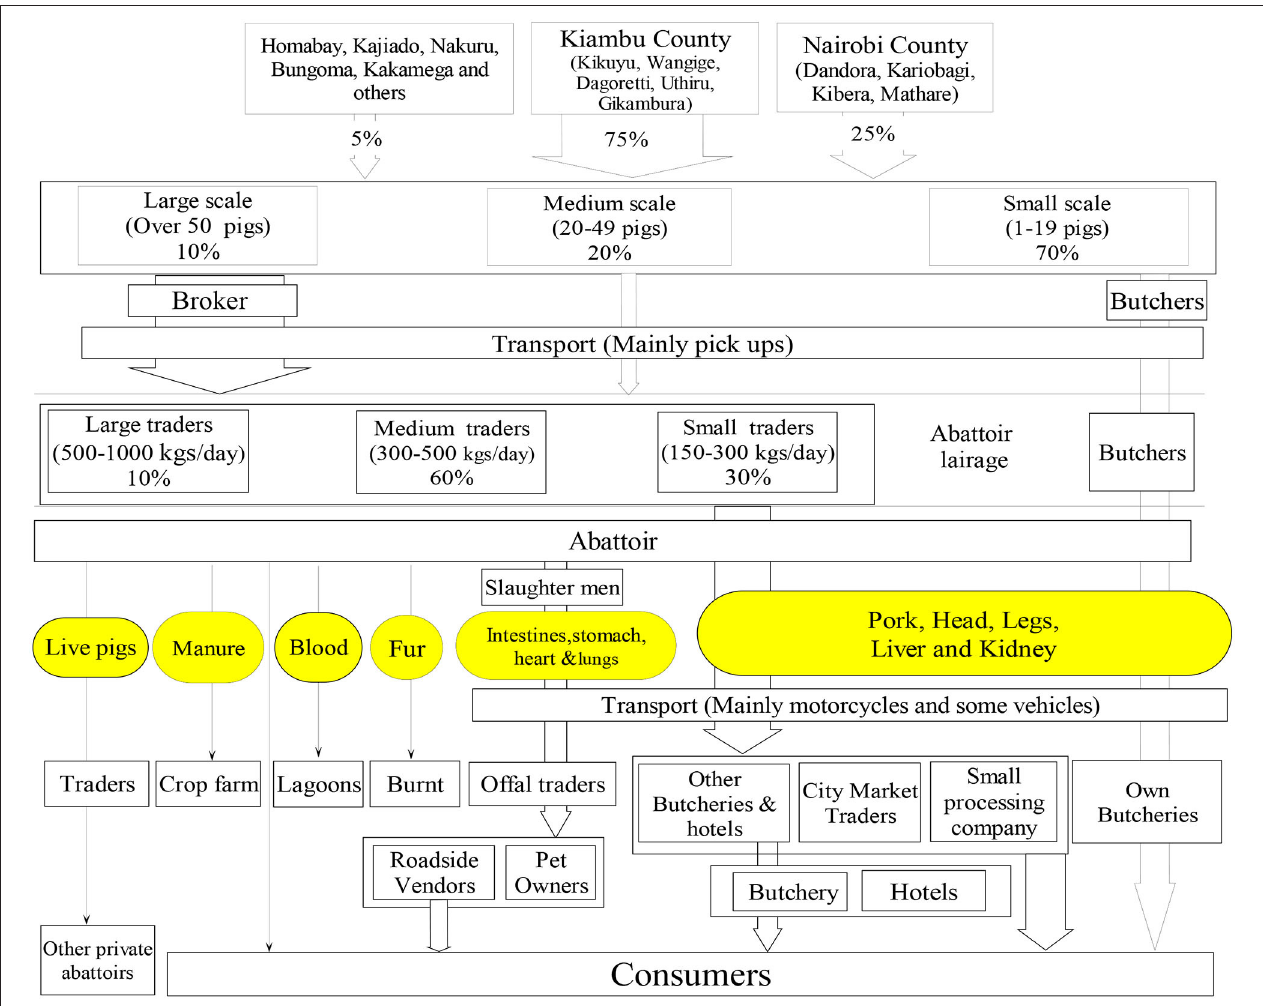
FIGURE 2 | Profile of people and product traded by abattoir A. Oval shapes colored yellow indicates commodities traded; arrows indicate the flows of products. The arrow width indicates proportional importance in terms of flow.